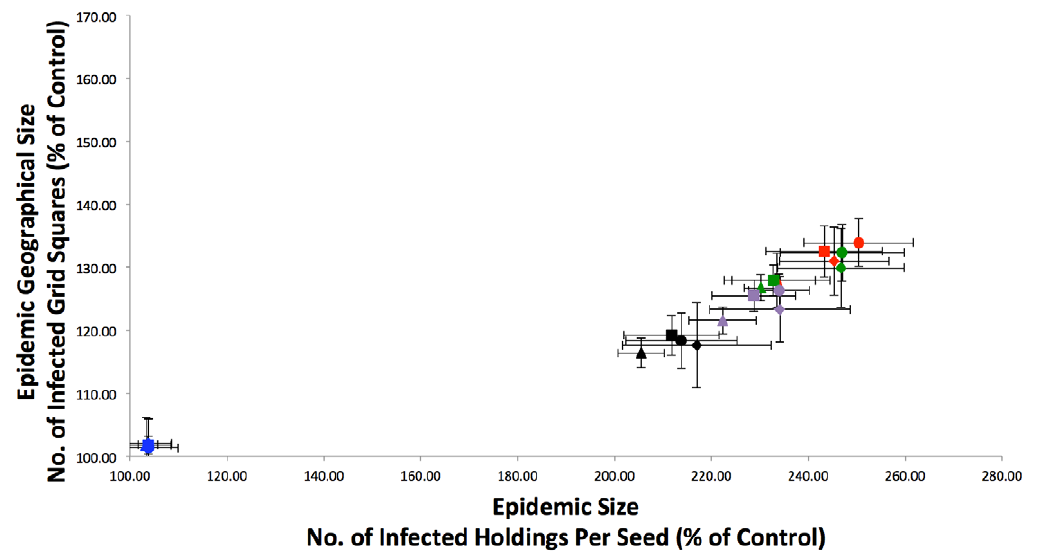
Figure 7. Comparison of epidemic sizes with SOAs. The model was run including SOAs, with no stock restriction on intra-SOA spread and the following distance limits on intra-SOA spread: No Limit (red), 50 km (green), 16 km (purple), and 8 km (black). In addition, the results from the SOA model with intra-SOA spread restricted to holdings with stock recorded as present is shown in blue. Epidemic size (number of infected holdings per seed) and geographical size (number of infected grid squares per seed) were firstly transformed into percentages of the control epidemic size (with no linked holdings) from the same time of year. Secondly, averages were then obtained for the four quarters of the year (Jan-Feb-Mar[squares], Apr- May-Jun [circles], Jul-Aug-Sep [triangles], Oct-Nov-Dec [diamonds]) giving four data points for each scenario. Error bars are associated with each quarterly average value that represent the 95% confidence intervals for that quarter, assuming a normal distribution and a standard deviation calculated from that quarter’s data.